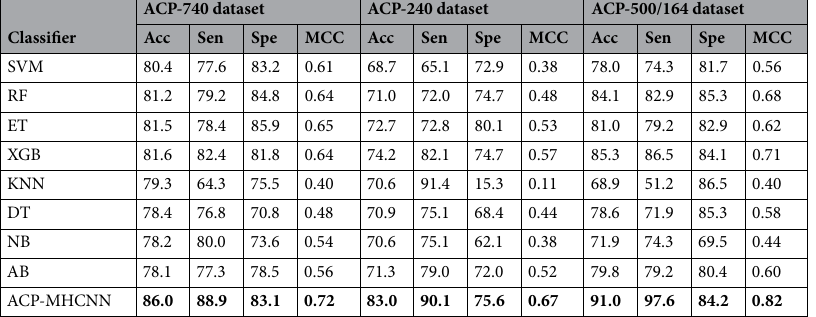
Table 9. The results achieved for ACP-MHCNN compared to traditional ML models on ACP-740, ACP-240, and ACP-500/164 using fivefold cross validation. Bold items indicate the best values found by the methods.